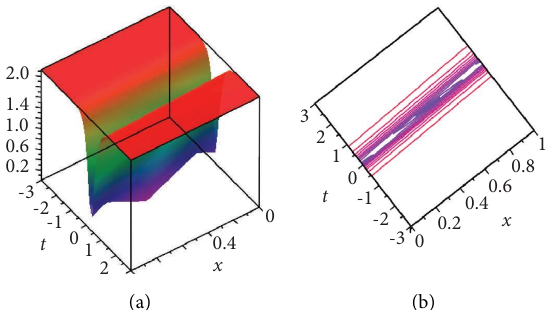
Figure 2: Te plot of the |(29)| for ϵ � 1, λ � 2 , σ � 4 , κ � − 2 , η � 1 , ε � 2 , χ � 2 , δ � 0 . 9 ,a � 3 . : (a) 3D plot and (b) contour